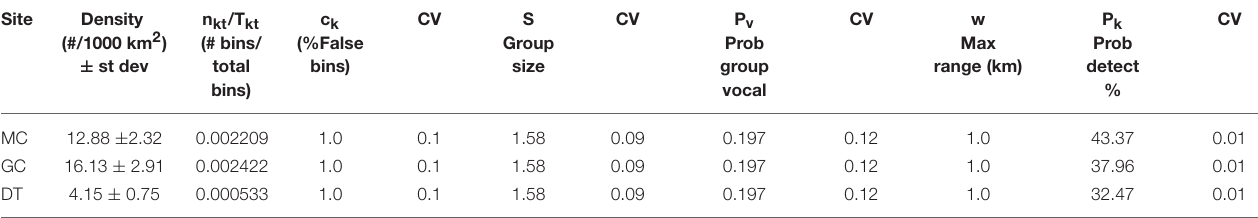
TABLE 5 | Average Kogia spp. densities derived from group counting by site (MC, GC, DT) given in # of animals per 1000 km 2